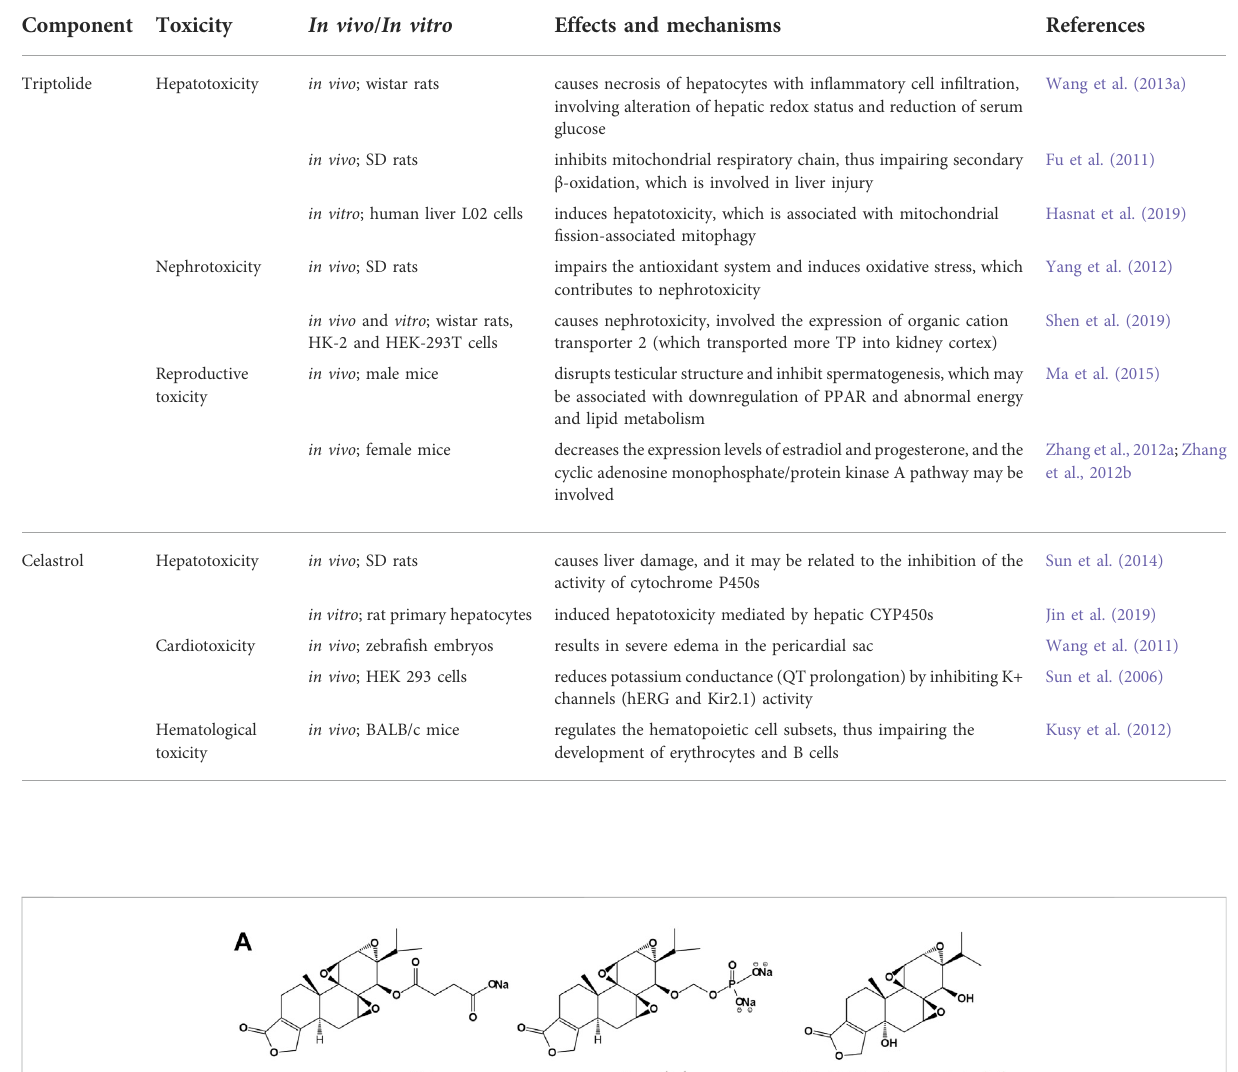
TABLE 2 Toxicity of triptolide and celastrol.